Question: Identify the chart type used in this figure.
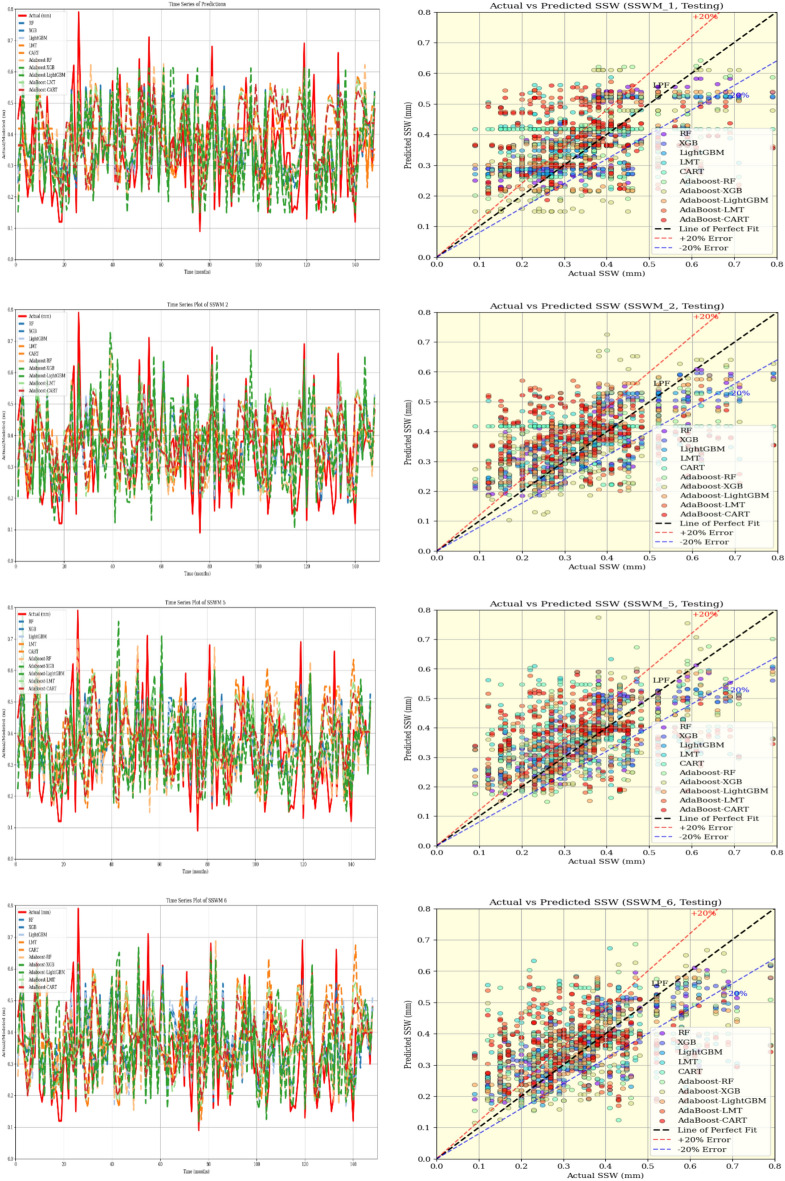
Answer: scatter